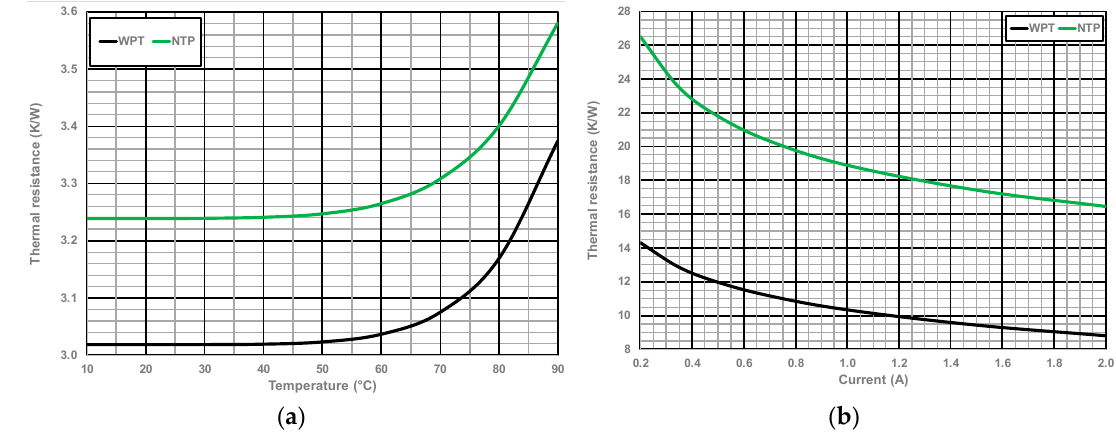
Figure 6. Modeling and simulation with Cauer RC ladder: ( a ) modeled values of the junction to solder point thermal resistance R1; ( b ) modeled values of the solder point to cold plate thermal resistance R2.